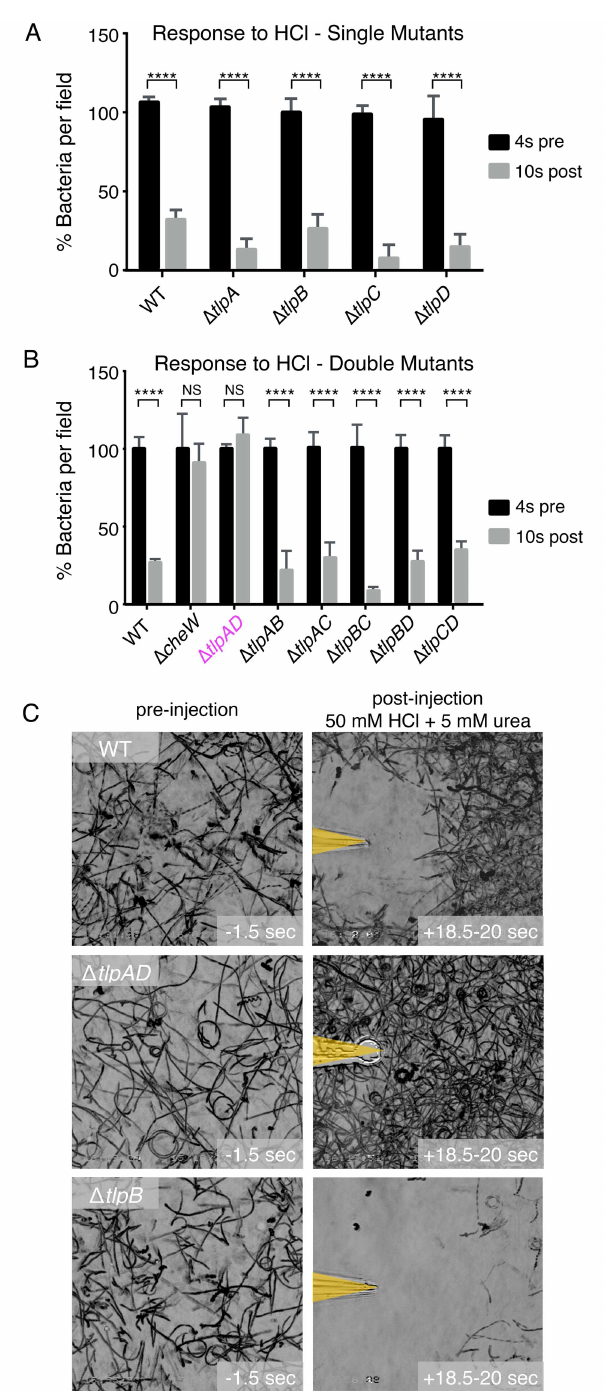
Fig 2. H . pylori expressestwo chemoreceptors that rapidly sense acid gradients. ( A ) Quantification of the responses of wild-type(WT) H . pylori vs. Δ tlpA , Δ tlpB , Δ tlpC , Δ tlpD to a 100 mM hydrochloric acid gradient. Temporal data of motility responses were collectedby videomicroscopy and quantifiedas in Fig 1C. The difference in bacterial density within the field of view at two time points, four secondsbefore the acid gradient(pre) and ten seconds after exposureto the acid gradient(post) is represented by bar graphs. ( B ) Quantification of the responses of WT H . pylori vs. Δ cheW , Δ tlpAD , Δ tlpAB , Δ tlpAC , Δ tlpBC , Δ tlpBD , Δ tlpCD to a 100 mM hydrochloric acid gradient. Each bar representsthe percent of bacteria in the field of view at four seconds pre-exposure and 10 seconds post-exposure to the gradient. ( C ) Still images of bacterial